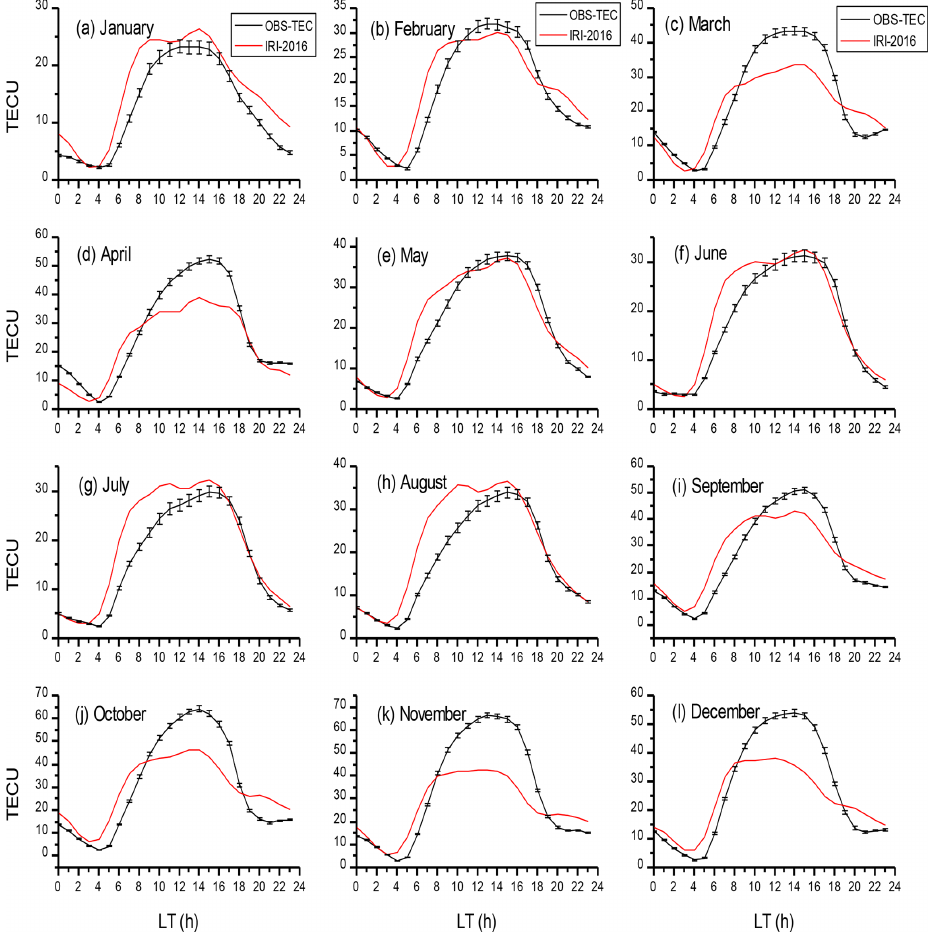
Figure 1. Diurnal variation in OBS-TEC, showing error bar and IRI-2016 model of each month during January–December 2011 at Birnin